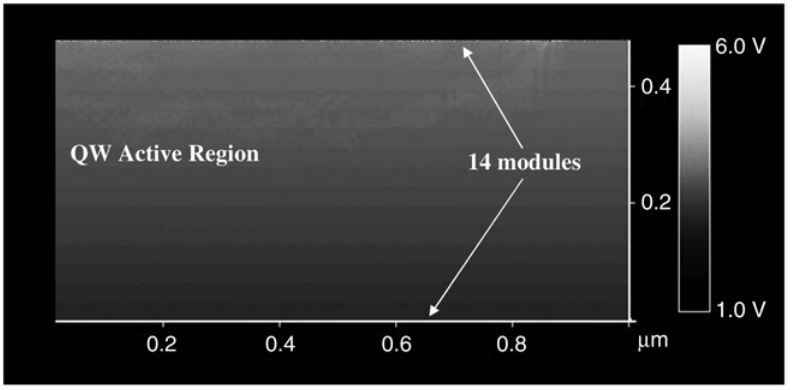
Figure 11: The zoomed-in SCM image over the active region of V843. The scan area is 1 × 0.5 μ m 2 and the scan rate is 0.25 Hz. Fourteen quantum cascade modules are delineated.